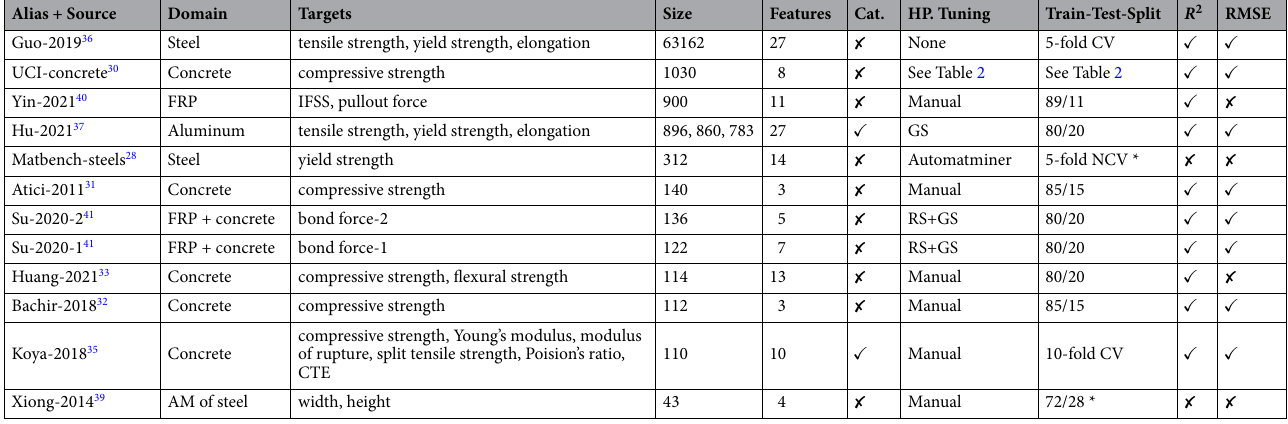
Table 1. Overview of investigated datasets ordered by size and their properties in the published version, the large, small and very small datasets are divided by the dashed line categorical features (cat.), interfacial shear strength (IFSS), coefficient of thermal expansion (CTE). *Exact train-test-split